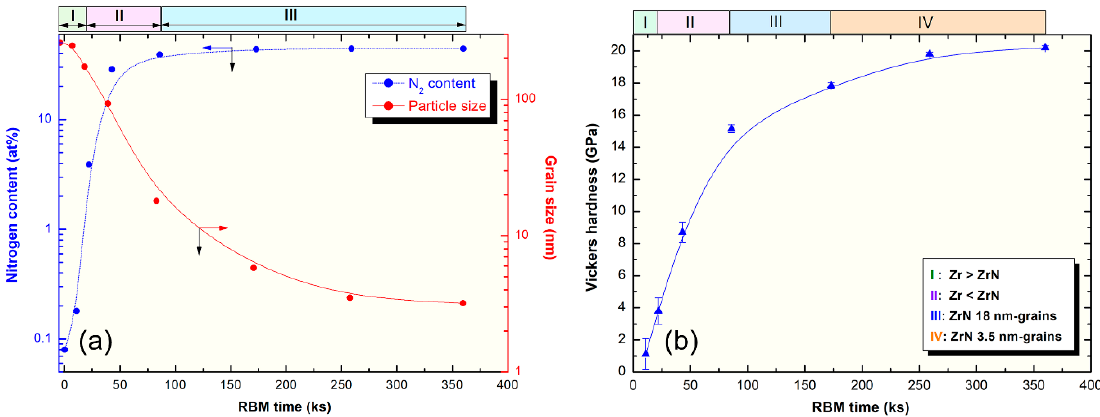
Figure 8. ( a ) Effect of the RBM time on the grain size, and nitrogen content upon high-energy milling of hcp-Zr metal under 70 bar nitrogen gas pressure; ( b ) influence of RBM time on the microhardness of ZrN consolidated buttons.